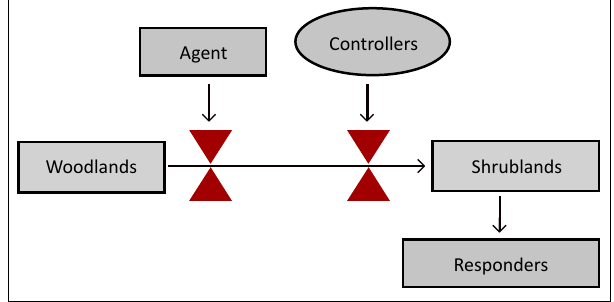
FIGURE 2: Interactions between agents (e.g. elephants) that act on a substrate (e.g. woodlands) to change it from one state to an alternative state (e.g. shrublands). However, the maintenance of the shrublands state is controlled by something else (e.g. kudu, impala and mice) other than the agent (adapted from Pickett, T.A., Cadenasso, M. & Benning, T., 2003, ‘Biotic and abiotic variability as key determinants of savannah heterogeneity at multiple spatiotemporal